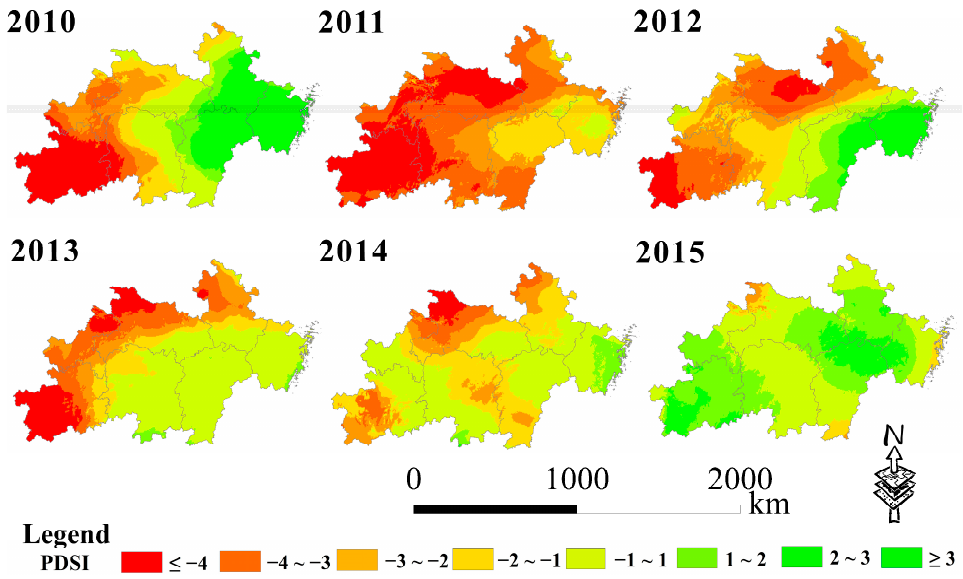
Figure 8. Spatial distributions of annual averages of the PDSI in the middle and lower reaches of the Yangtze River in China from 2010 to 2015.